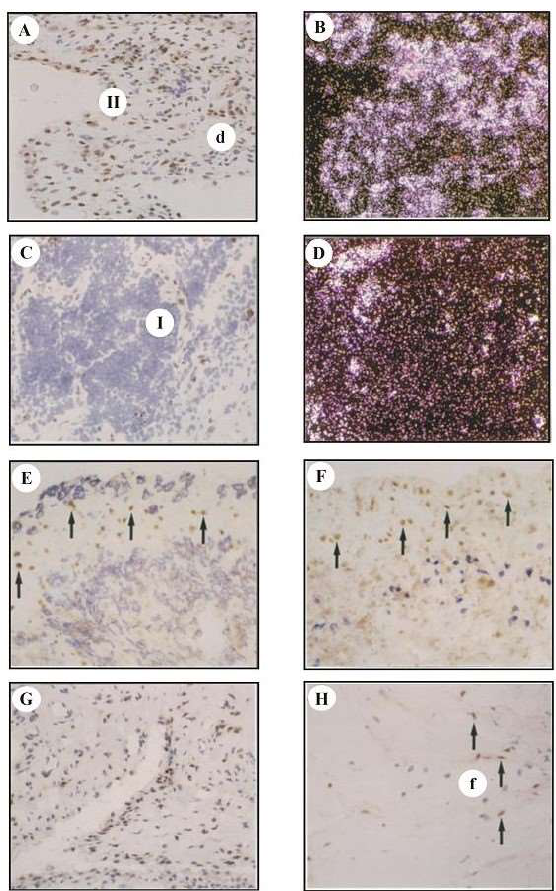
Figure 2. Detection of cFos mRNA and protein in SM cryostat sections by immunohistochemistry and in situ hybridization. ( A , C ) Immunohistochemical detection of cFos protein in RA-SM samples. Staining for cFos was observed in numerous cell nuclei in the lining layer ( II in A ), di ff use infiltrates ( d in A ), and in individual cell nuclei in lymphoid follicles ( I in C , nuclear counterstaining by hematoxylin). ( B , D )InsituhybridizationusingspecificRNAprobesfor cfos inRA-SMsamples. Thedistributionpattern of cfos mRNA was similar to that of cFos protein. ( E , F ) Double-staining for cFos protein (peroxidase; brown) and the macrophage marker CD14 (APAAP; blue; E ) or the T-cell marker CD3 (APAAP; blue; F ) in RA-SM, showing a positive signal for cFos (examples indicated by arrows in E / F ) mainly in CD14-negative ( E ), CD3-negative ( F ) cells, identifying these cells as non-macrophages / non-T-cells. ( G ) Immunohistochemical detection of cFos protein in OA-SM samples. Staining for cFos in cells of the lining layer, di ff use infiltrates, fibrous areas, and endothelia was observed in a lower number of positive cells as compared to RA ( A ). ( H ) Immunohistochemical detection of cFos protein in JT-SM samples. Staining for cFos was observed in a lower number of positive cells as compared to RA ( A ) in stromal fibrous areas ( f in H ; arrows indicate positive nuclei), interrupting small areas of infiltrating cells. Original magnification for A – H 184 ×